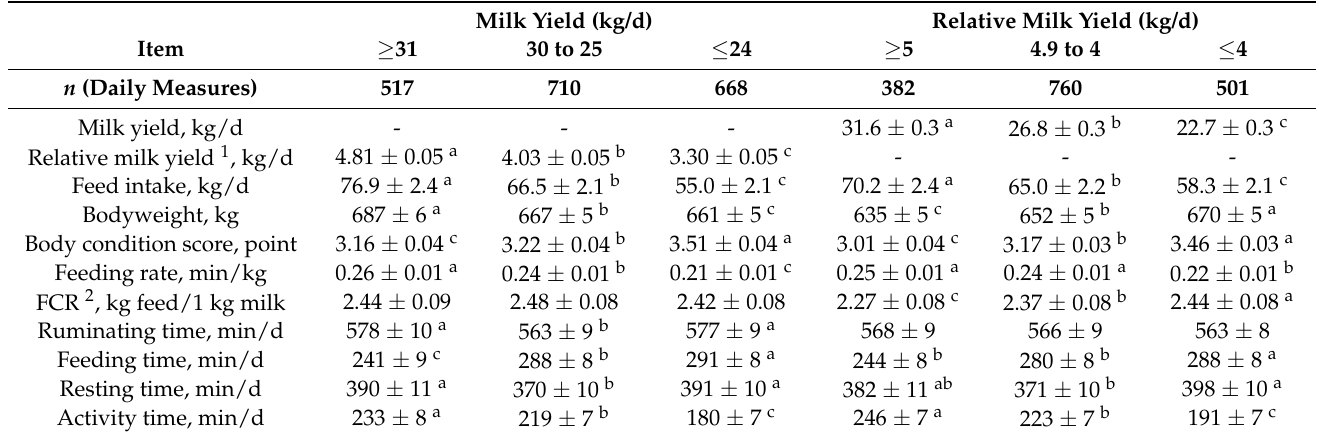
Table 2. Effects of milk yield and relative milk yield 1 on evaluated variables. Milk Yield